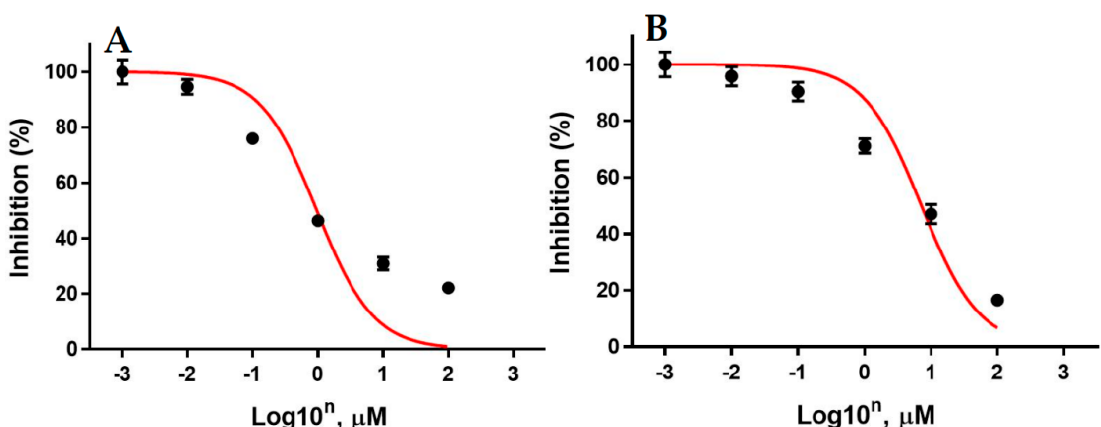
Figure 8. In vitro inhibition of CDK1 by compounds 5b ( A ) and 5f ( B ). The inhibitory effect of pyranopyrazoles on CKD1 measured using ADP − Glo™ reagent. The CDK1 reaction was performed in 1X reaction buffer and the compounds were added to the plates and incubated for 20 min, followed by the addition of ATP/substrate solution to initiate the reaction. CDK1 was added and the reaction was incubated for 40 min. We used positive controls without any compounds to calculate the activity of the kinase at 100%. To determine 0% kinase activity, negative controls were used since they did not contain any compound or enzyme. TM313 specifies the method of dispensing ADP − GloTM Kinase Assay reagents.